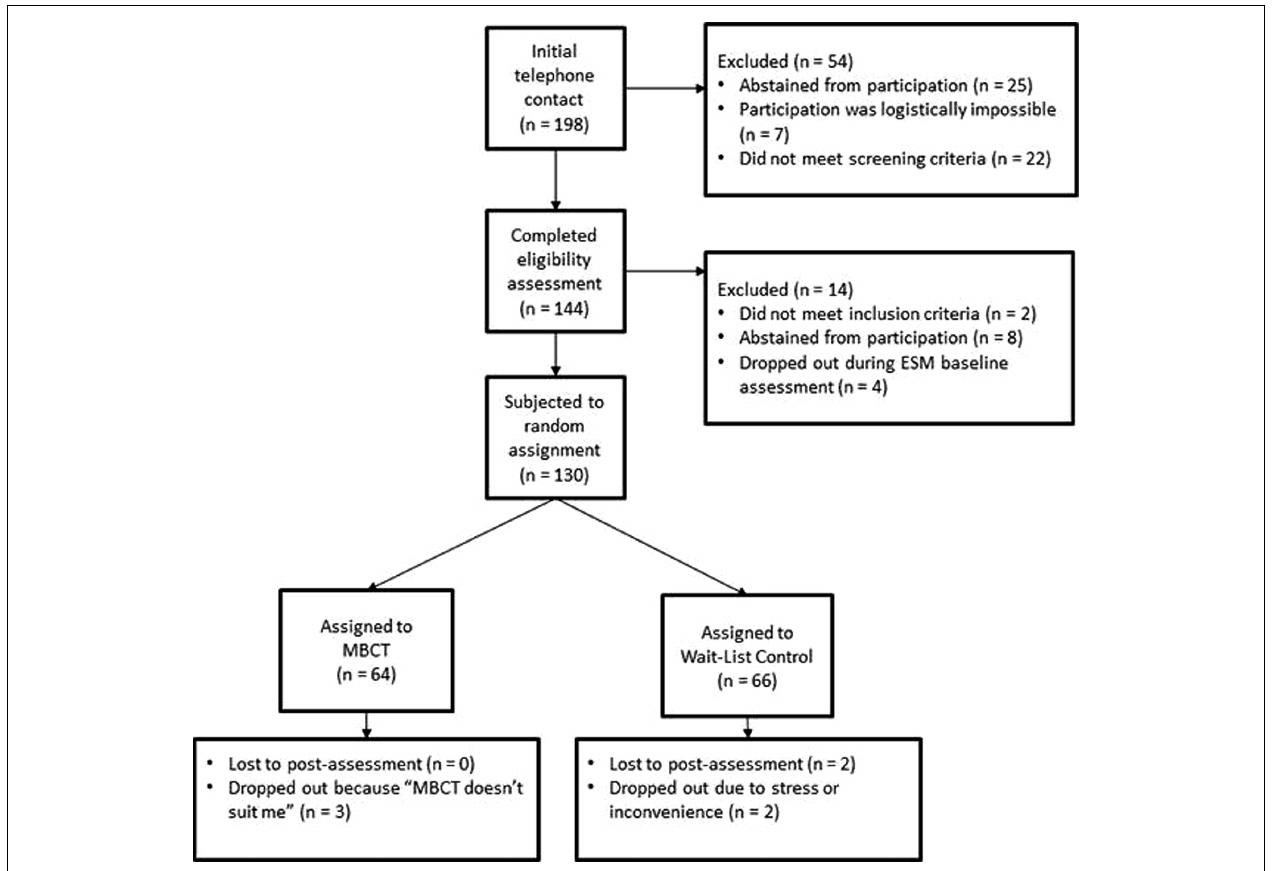
FIGURE 1 | Study flow